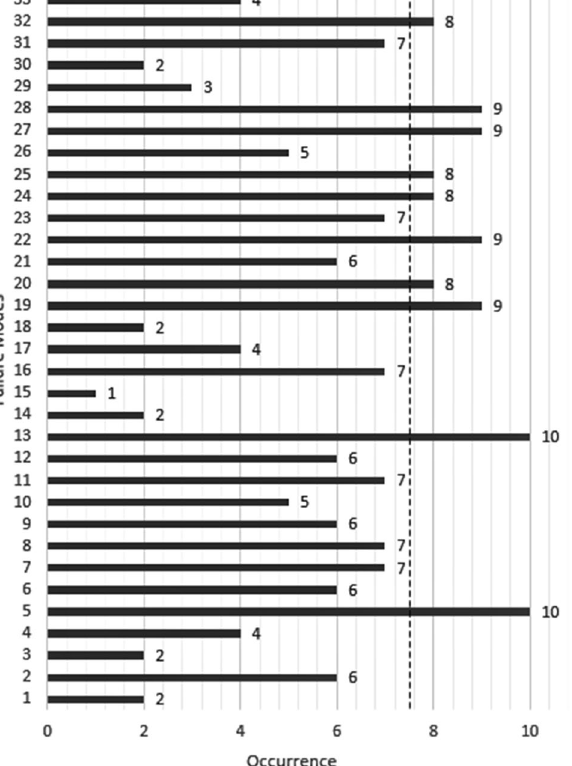
Fig. 6 Comparative chart of "Occurrence" values